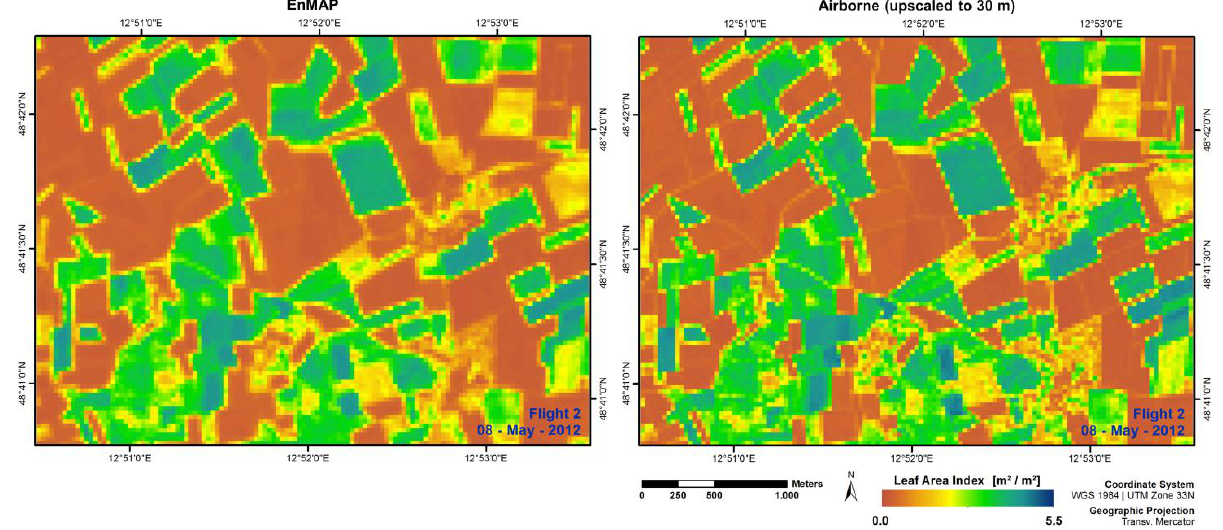
Figure 7. Comparison of estimated LAI (8 May 2012), which was derived by the adapted LUT algorithm from simulated EnMAP data ( Left ) and upscaled (from 4–30 m) LAI estimation based on the 4 m airborne data ( Right